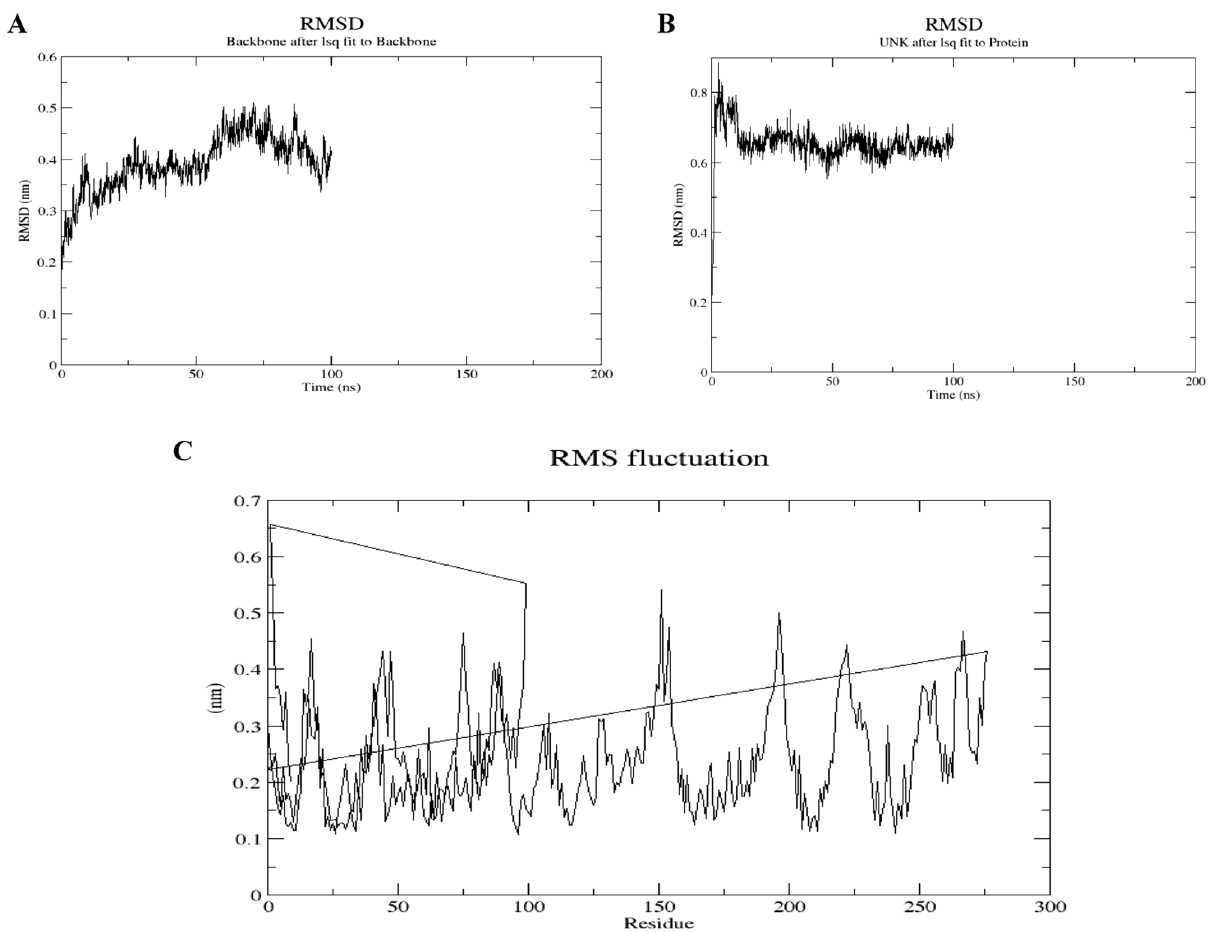
Figure 11. Molecular dynamic simulation, ( A ) The RMSD profiles of the protein backbone, ( B ) The RMSD profiles of the complex, ( C ) The RMSF profile of the complex.